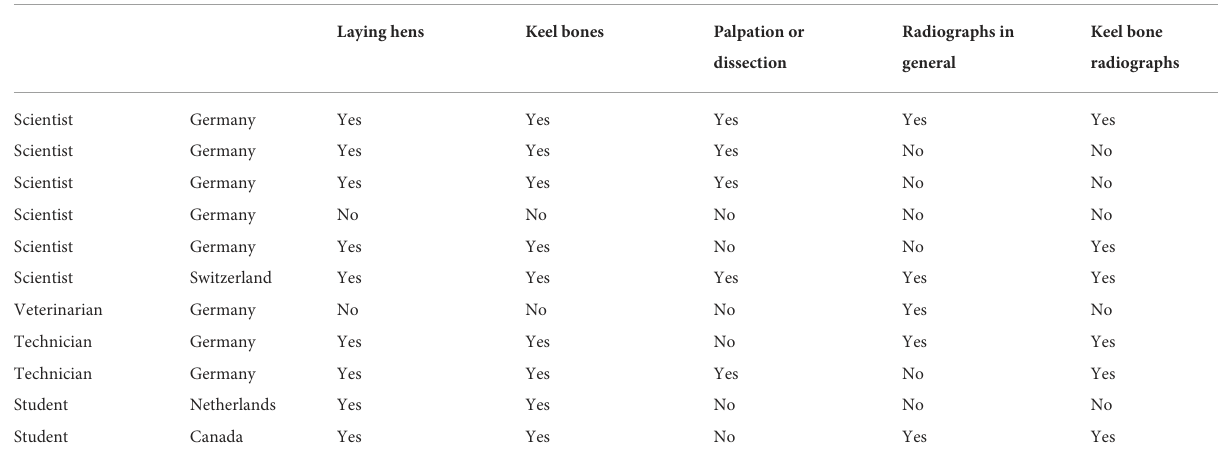
TABLE 1 Country, background, and experience of participants of the reliability trial for the assessment of keel bone deviations in laying hens on radiographs. Background Country Experience with Laying hens Keel bones Palpation or